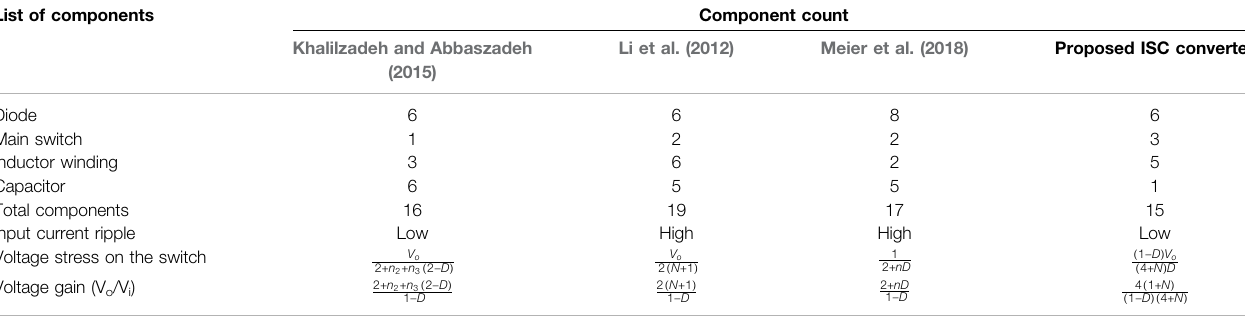
TABLE 1 | Constructional components comparison of the DC – DC converters. List of components